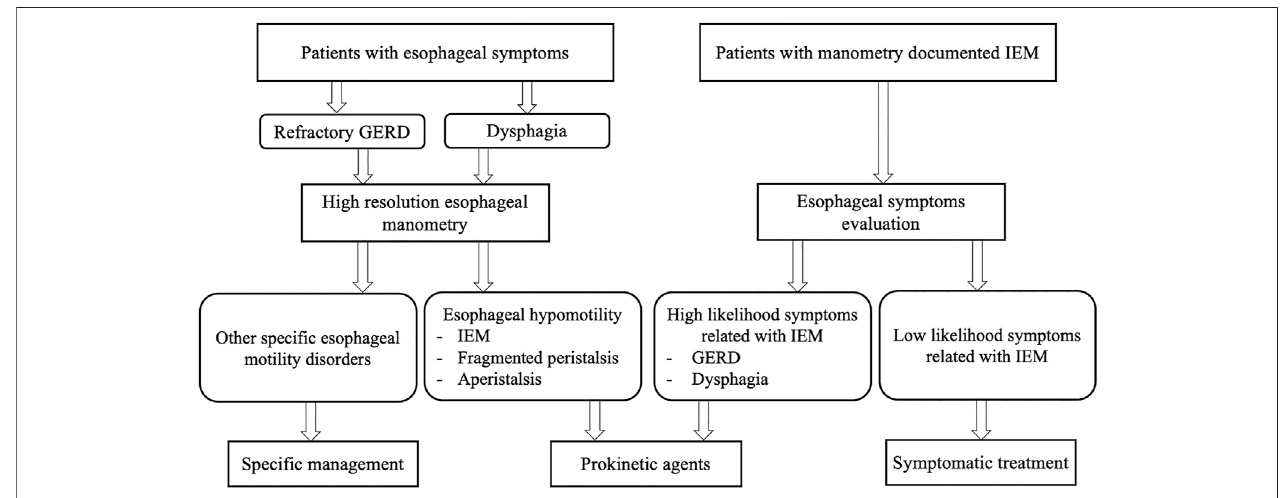
FIGURE 2 | Algorithm for decision making on prokinetic prescription in patients with esophageal hypomotility. IEM, ineffective esophageal motility; GERD, gastroesophageal re fl ux disease.